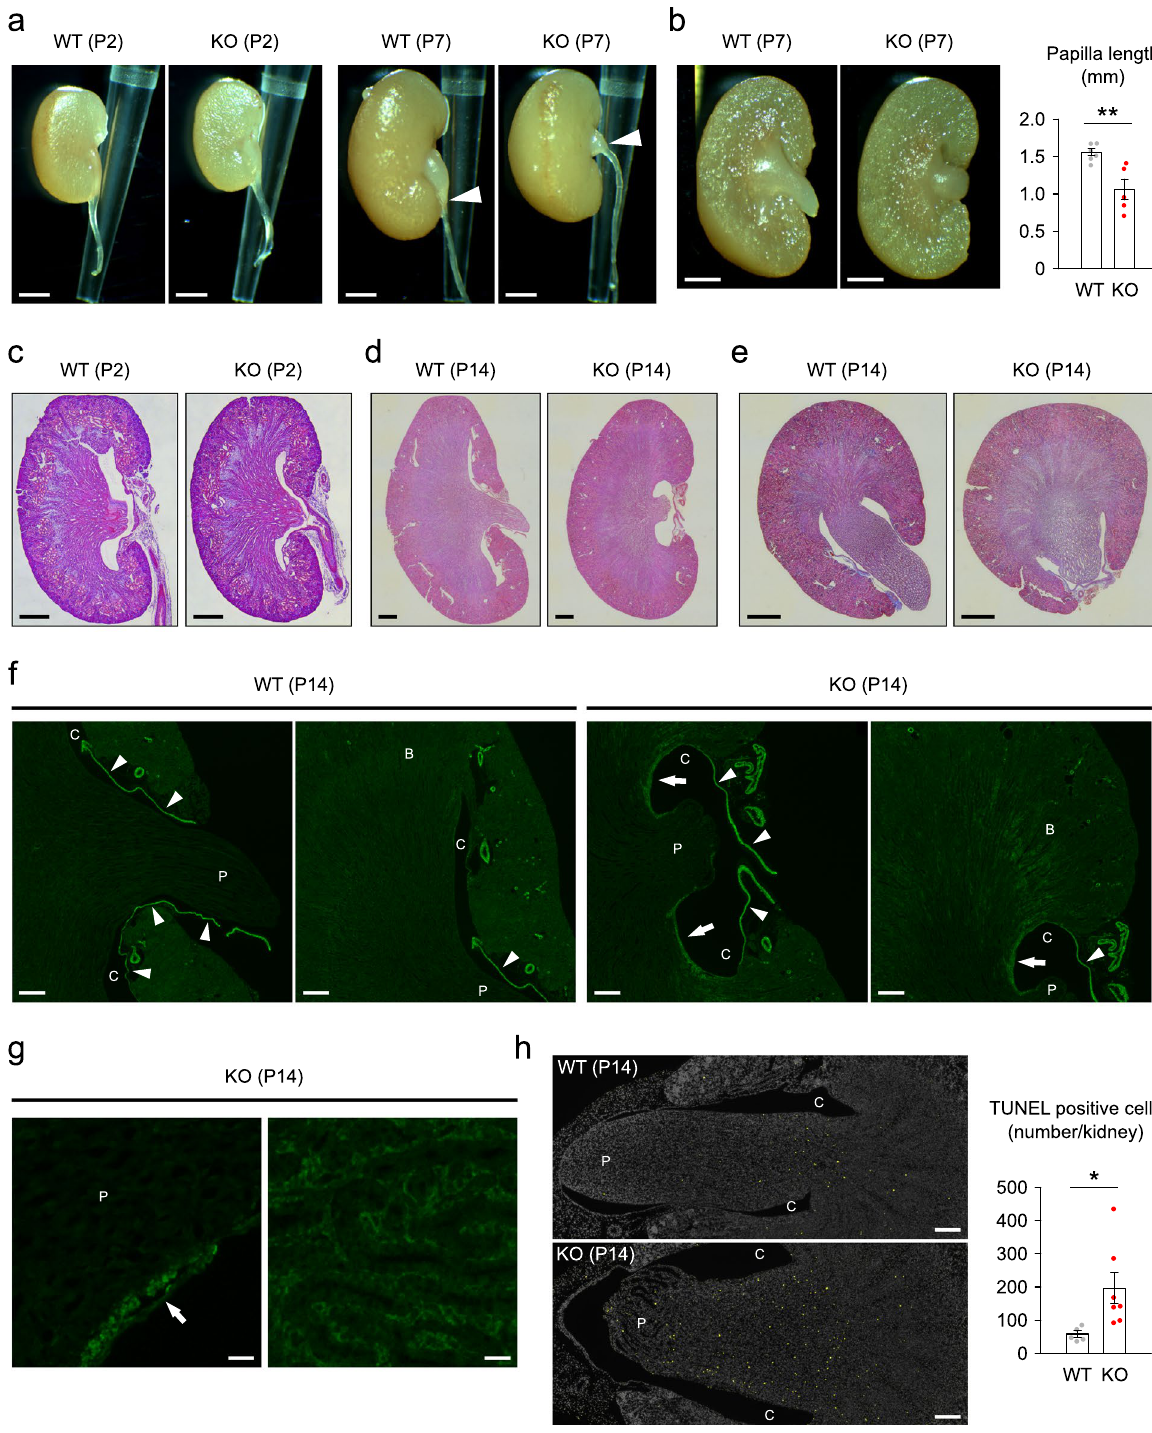
Figure 4. Rac1 deficiency in distal tubules disrupts elongation of renal papilla during postnatal period and causes damage. ( a ) Representative photomicrographs of the kidneys and ureters of WT and KO mice at postnatal day 2 (P2) and day 7 (P7). Arrowheads indicate the tip of papilla. ( b ) Coronal sections of the kidneys and quantification of the papilla length ( n = 5–6 per group). ( c , d ) Coronal sections of the kidneys at P2 (C) and P14 (D) stained with hematoxylin and eosin. ( e ) Transverse sections of the kidneys at P14 stained with Masson’s trichrome. ( f ) Immunofluorescent staining of α-SMA (green) in coronal sections of the kidneys at P14. P: papilla, C: calyces, arrowheads: wall of ureter. In KO mice, slight positive staining for α-SMA is observed in some parts of the wall of the papilla and calyces (arrows) and in some interstitial area at the corticomedullary border (B). ( g ) Magnified image of α-SMA staining. P: papilla. Arrow: α-SMA-positive wall of papilla. Positive staining for α-SMA is observed in the wall of papilla (left) and interstitium of corticomedullary border (right). ( h ) TUNEL (yellow) staining in transverse sections of the kidneys. Nuclei were counterstained with DAPI (gray). P: papilla, C: calyces. The bar graph shows the counts of TUNEL-positive cells in the kidneys ( n = 5–7 per group). Data are expressed as mean ± SEM. Statistical significance was analyzed by unpaired t test. * P < 0.05; ** P < 0.01; N.S.: not significant. Scale bars, 1 mm ( a , b ); 200 μm ( c , f , h ); 500 μm ( d , e ); 20 μm ( g